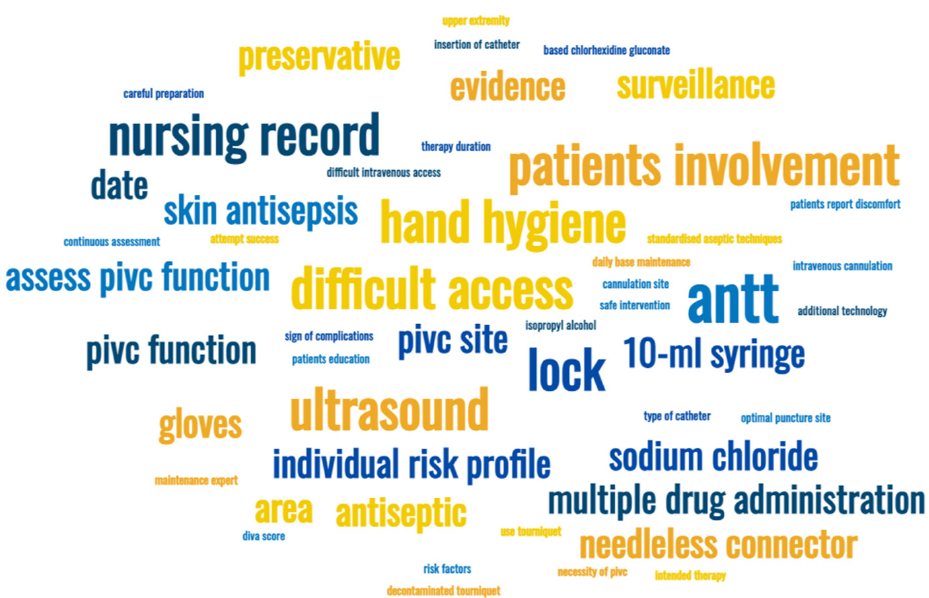
Figure 2. Word map reflecting the initial item pool.